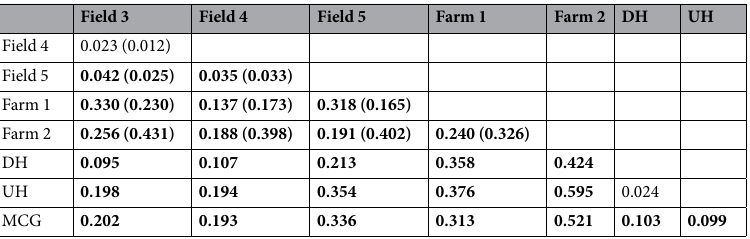
Table 4. Pairwise index of population differentiation ( Φ PT ) between Cercospora beticola populations collected from New York (Farm 1, Farm 2, Field 3, Field 4 and Field 5) and Hawaii (DH, EH, and MCG), 2015. Φ PT for the clone-corrected data set (indicated in parentheses) was not calculated for the Hawaiian populations due to the small population sizes. Significant differentiation ( P < 0.05) is indicated in